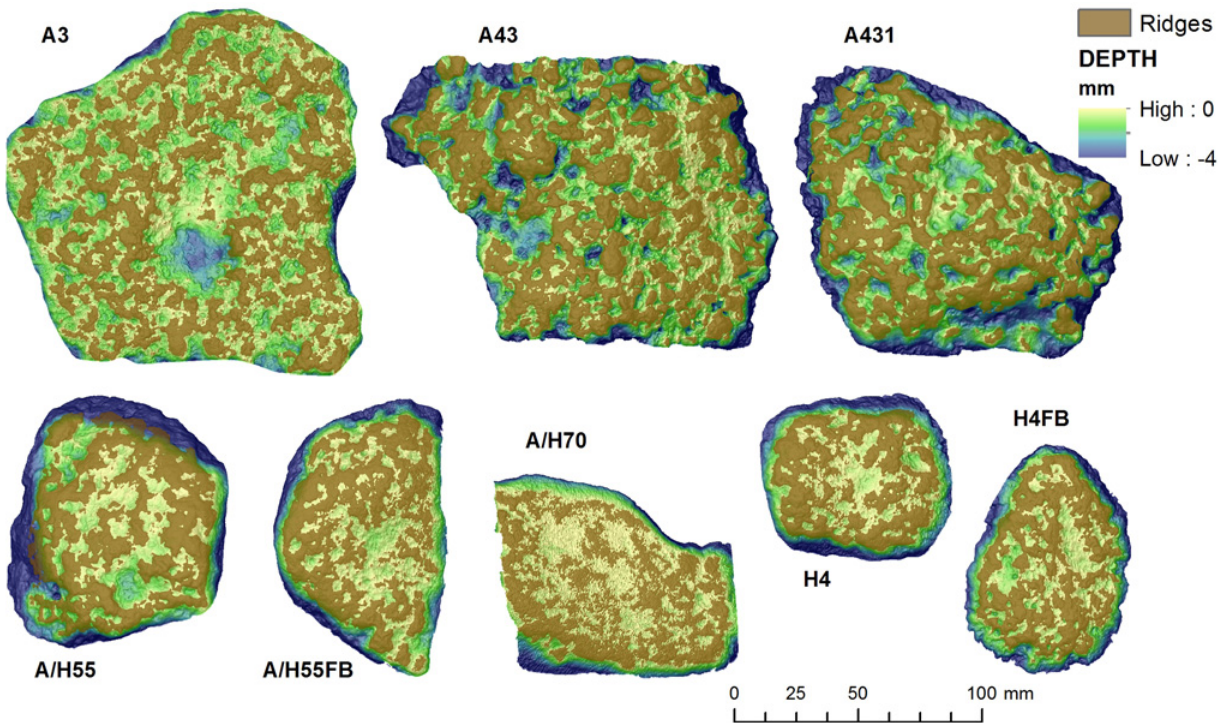
Fig 5. Relative depth model of artifact surfaces. These models calculated by subtracting the DEM from TPS models (Top Potential Surface), which represents the interpolated surface joining the highest points of the ridges.